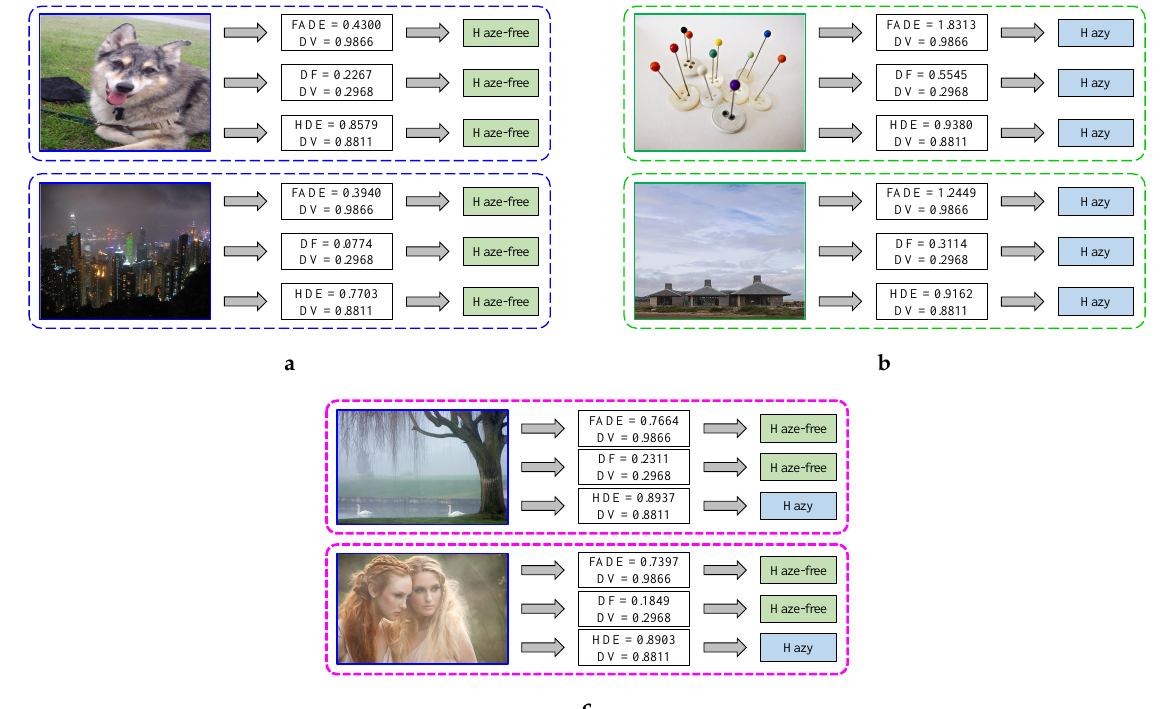
Figure 14. A comparison of the proposed evaluator with state-of-the-art evaluators: ( a ) false-negative cases, ( b ) false-positive cases, and ( c ) superior